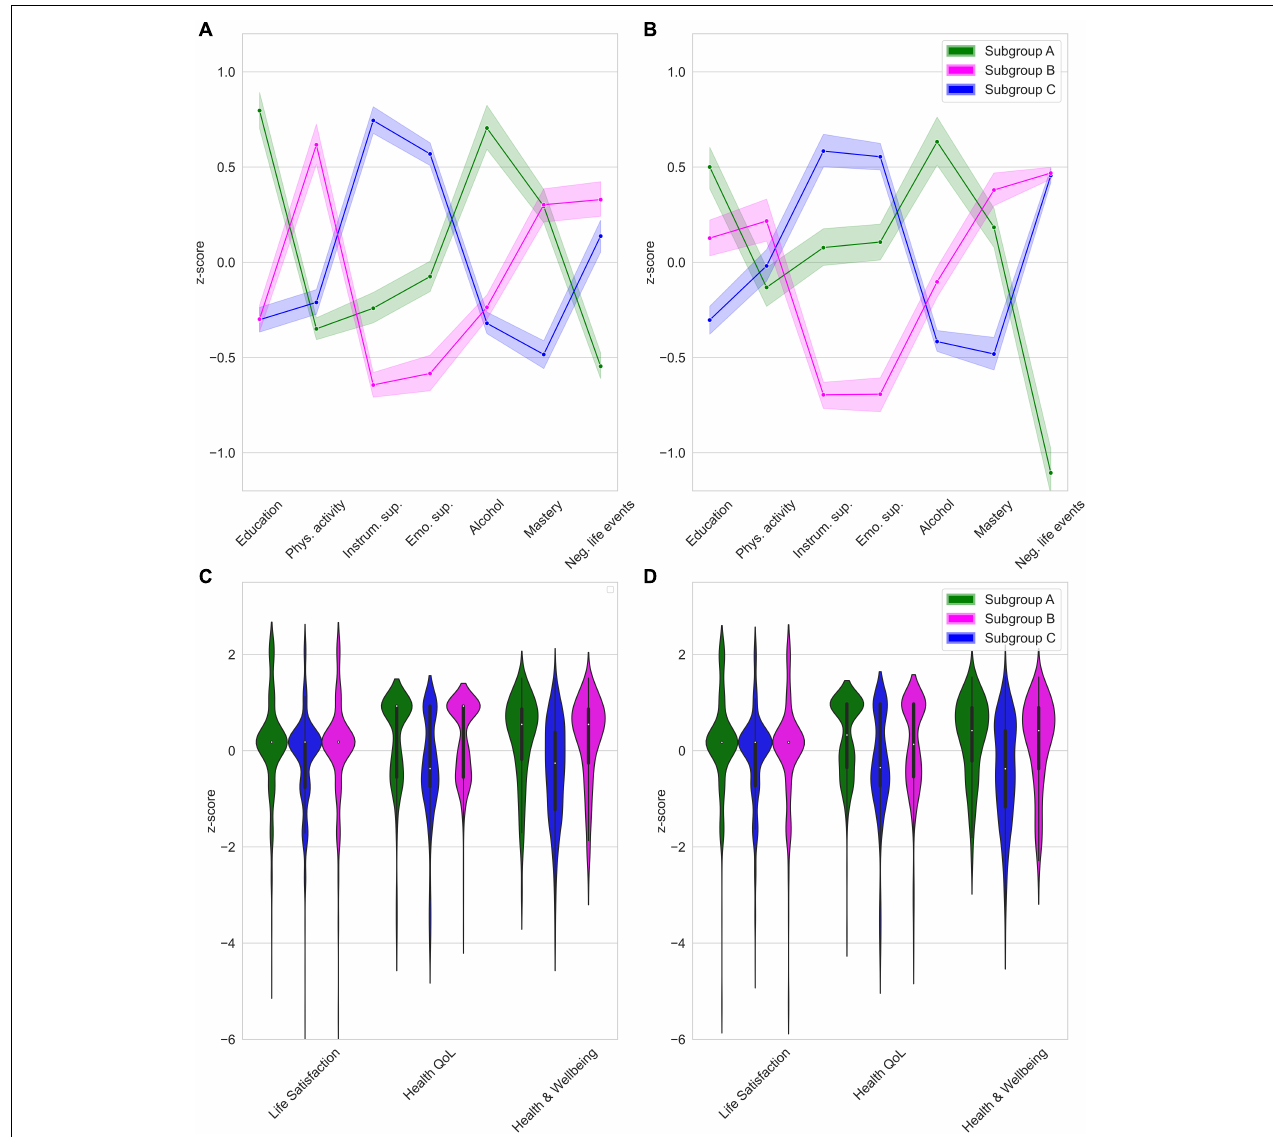
FIGURE 1 | (A) Subgroup profiles at T1, (B) Subgroup profiles at T2, (C) External validation (T1), (D) Predictive validation (T2). Scores as shown as z -scores based on the total sample mean. Shaded area represents 95%-confidence interval.